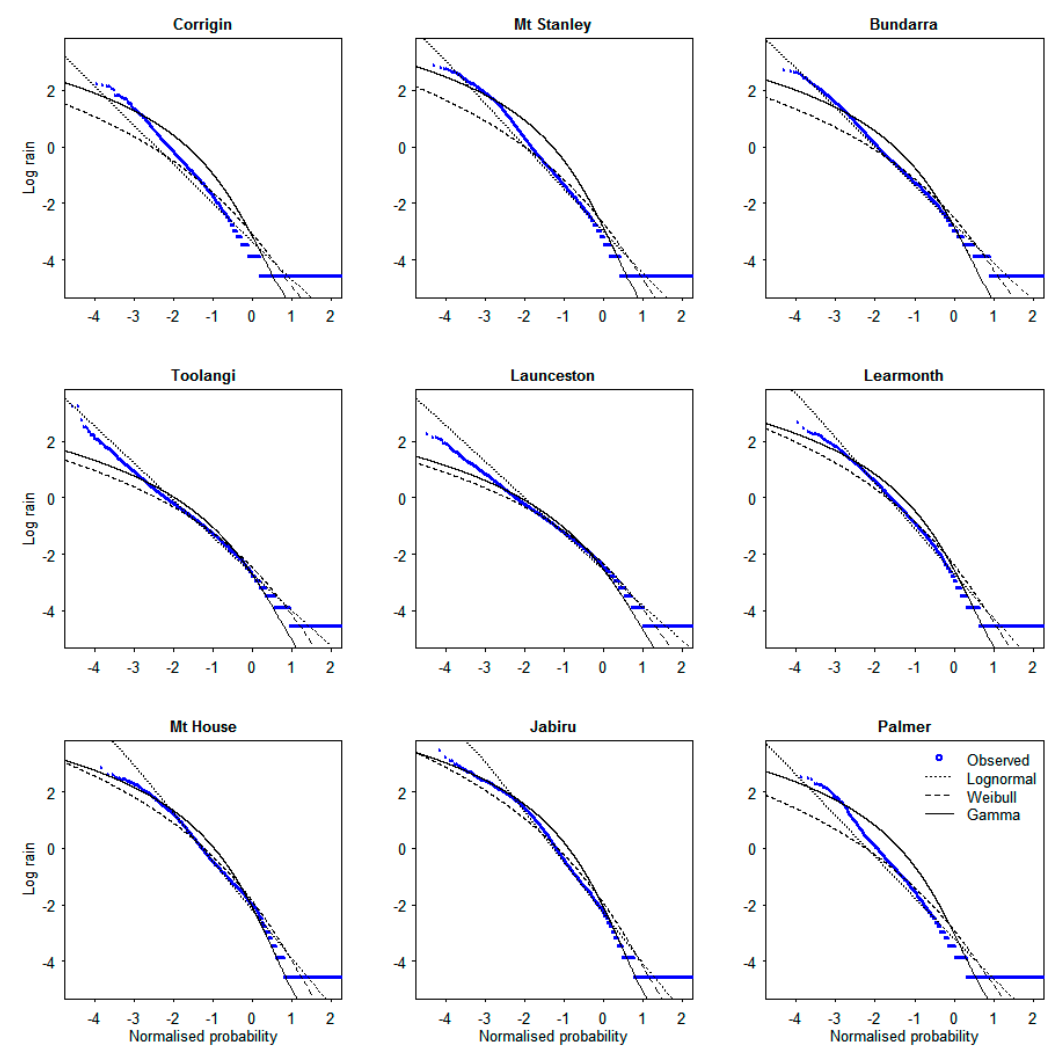
Figure 2. Logarithm of rainfall verses normalised probability of observed and modelled rainfall using Gamma, Weibull and Lognormal distributions.